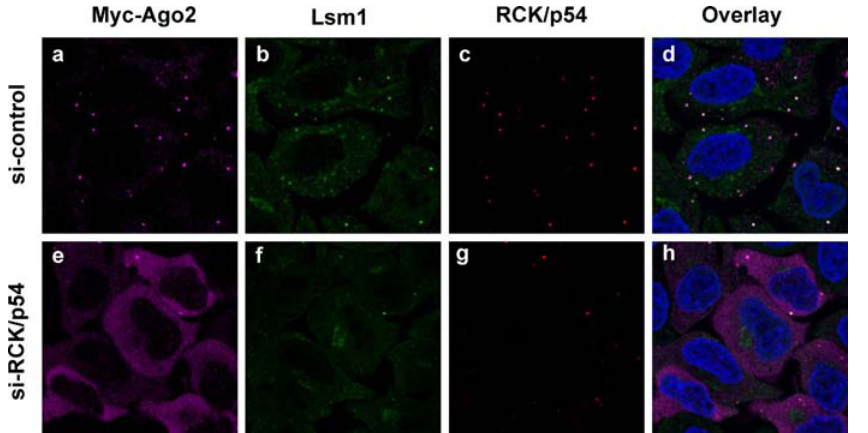
Figure 4. Depletion of RCK/p54 Disrupts P-bodies and Disperses the Localization of Human Ago2 HeLa cells were co-transfected with Myc-Ago2 and siRNA against human RCK/p54 (lower panels) or CDK9 mismatch (control; upper panels). At 24 h post-transfection, cells were analyzed by immunofluorescence using antibodies against Myc-Ago2 (A and E) and against the P-body proteins Lsm1 (B and F) and RCK/p54 (C and G). Cells were stained with Hoechst 33258 to visualize nuclei and images were digitally merged (D and H). DOI: